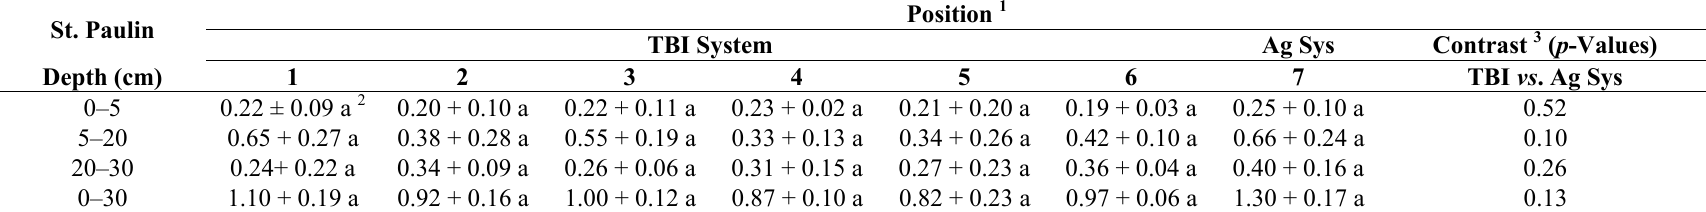
Table 5. Average soil N stocks (kg N m − 2 ± standard deviation, n = 3) for a tree-based intercropping (TBI) system and an adjacent agricultural system (Ag Sys) at St. Paulin, southern Quebec, Canada.